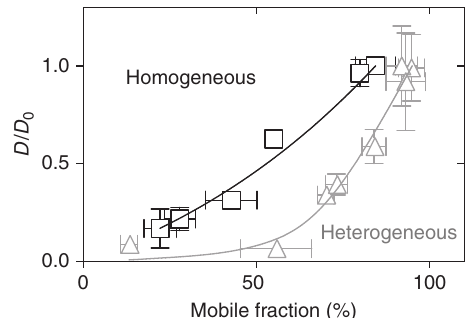
Figure 3 | VSG diffusion depends on the density and homogeneity of the protein layer. Comparison of the diffusion coefficients and the corresponding mobile fractions in homogenous VSG (black squares) and VSG/NeutrAvidin layers (grey triangles, cf. Fig. 2). Diffusion coefficients ( D ) are normalized to the values for the most dilute situation ( D 0 ). The solid lines represent the fit according to equation (6). Data are presented as means ±